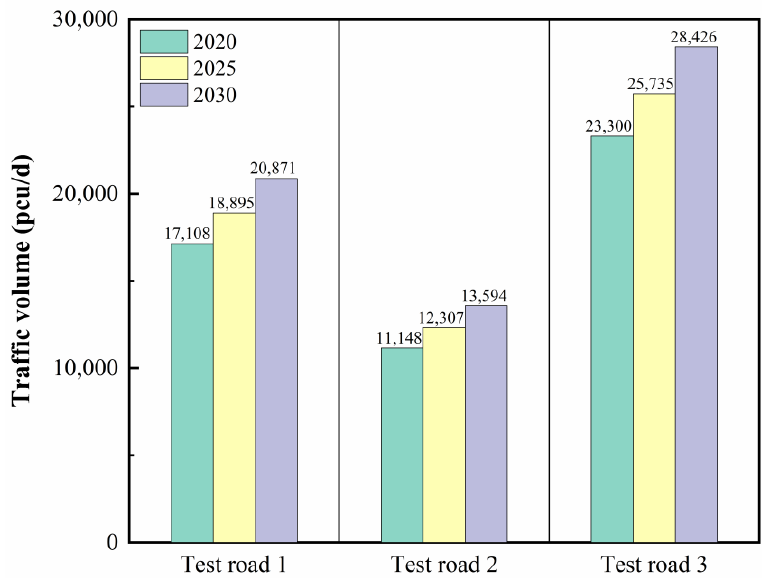
Figure 2. Original defects of the test roads.